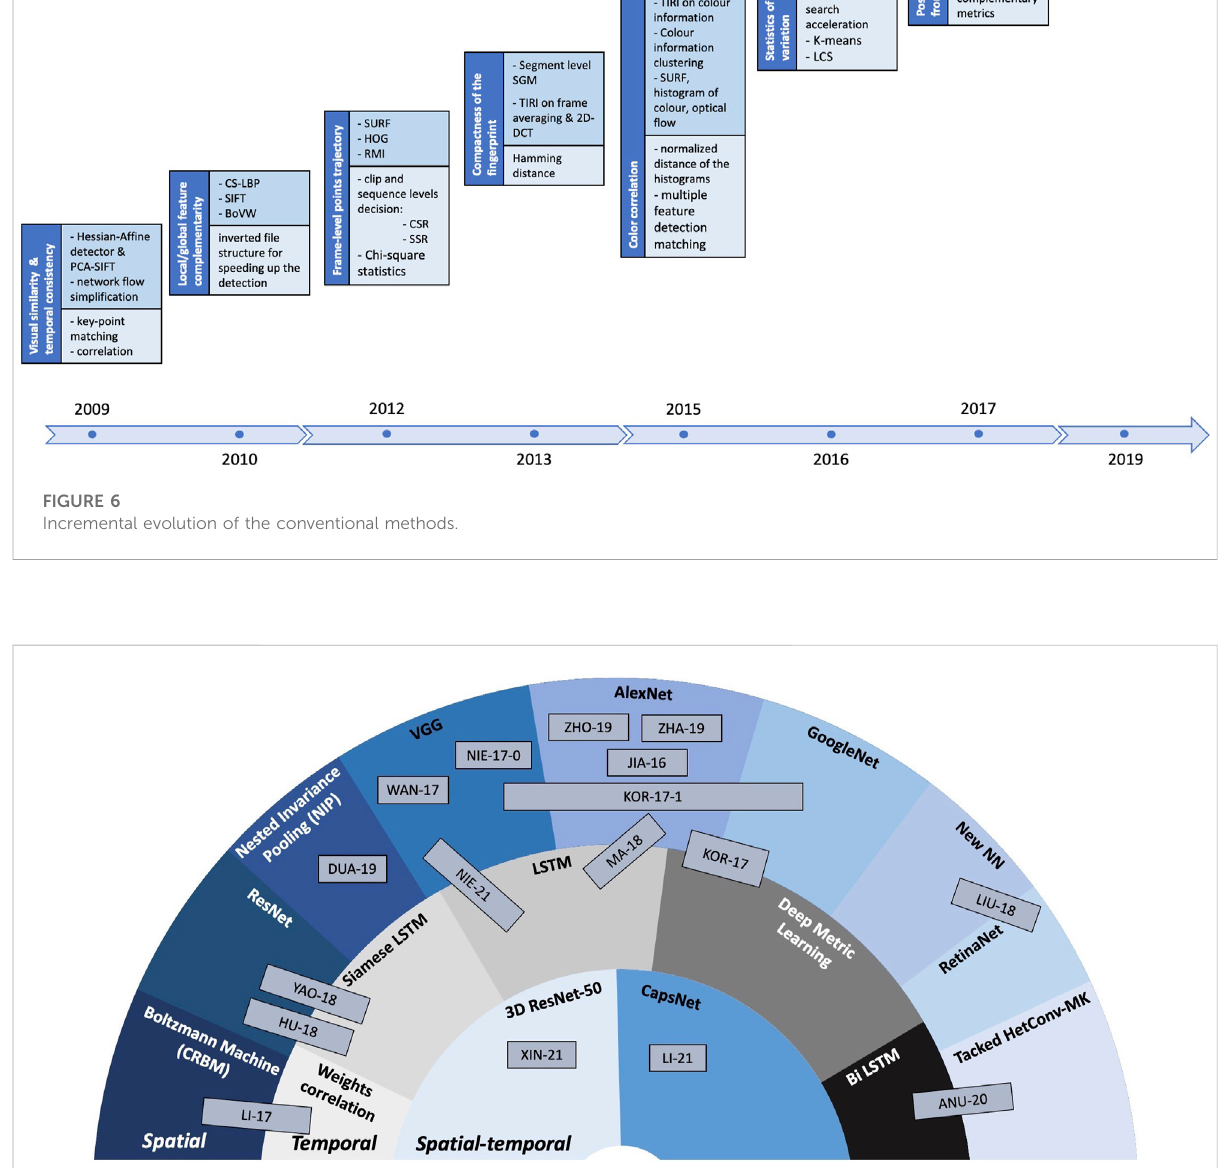
Frontiers in Signal